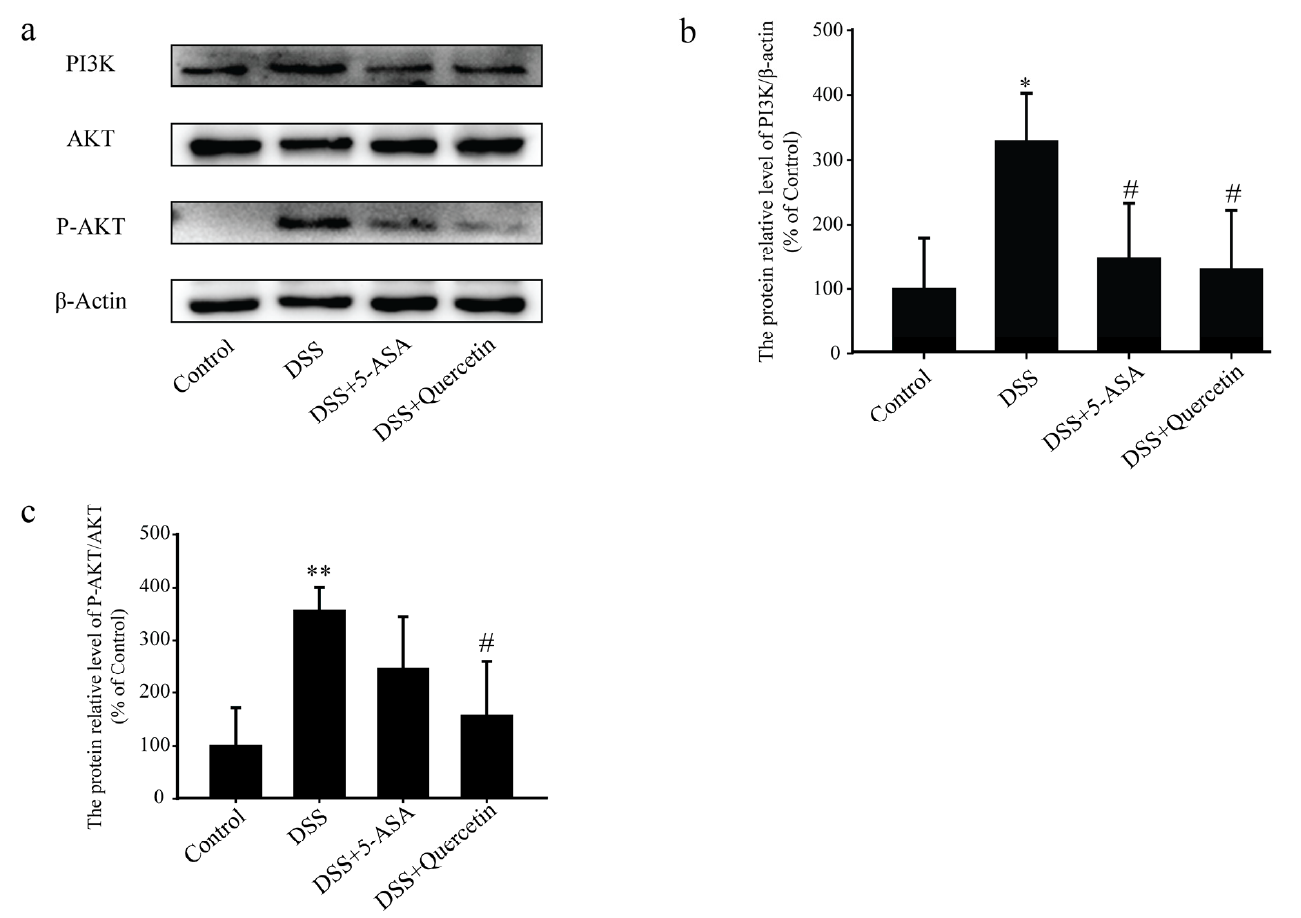
Figure 6. The anti-colitis effects of quercetin are mediated by inhibition of the dextran sodium sulfate (DSS)-induced phosphatidylinositol 3-kinase (PI3K)/protein kinase B (AKT) signaling pathway and the expression of inflammatory mediators. ( a – c ) Western blotting analysis of PI3K, AKT and phosphorylated (P)-AKT in colonic tissue extracts. * p < 0.05, ** p < 0.01 compared with the control group; # p < 0.05, ## p < 0.01 compared with the DSS group.